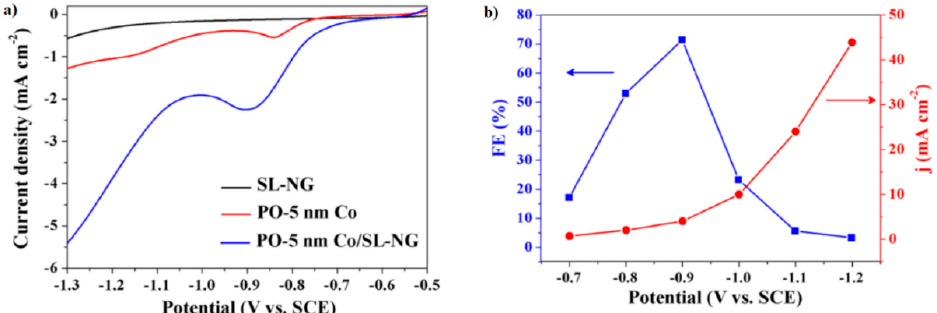
Figure 11. ( a ) Linear sweep voltammograms of single-layer nitrogen-doped graphene (SL-NG), 5-nm cobalt nanoparticles (PO-5 nm Co) and PO-5 nm Co/SL-NG in 0.1 M NaHCO 3 at 20 mV s − 1 . ( b ) FE of methanol and current density for PO-5 nm Co/SL-NG under various electrolysis potentials for 10 h. Reproduced with permission [19].